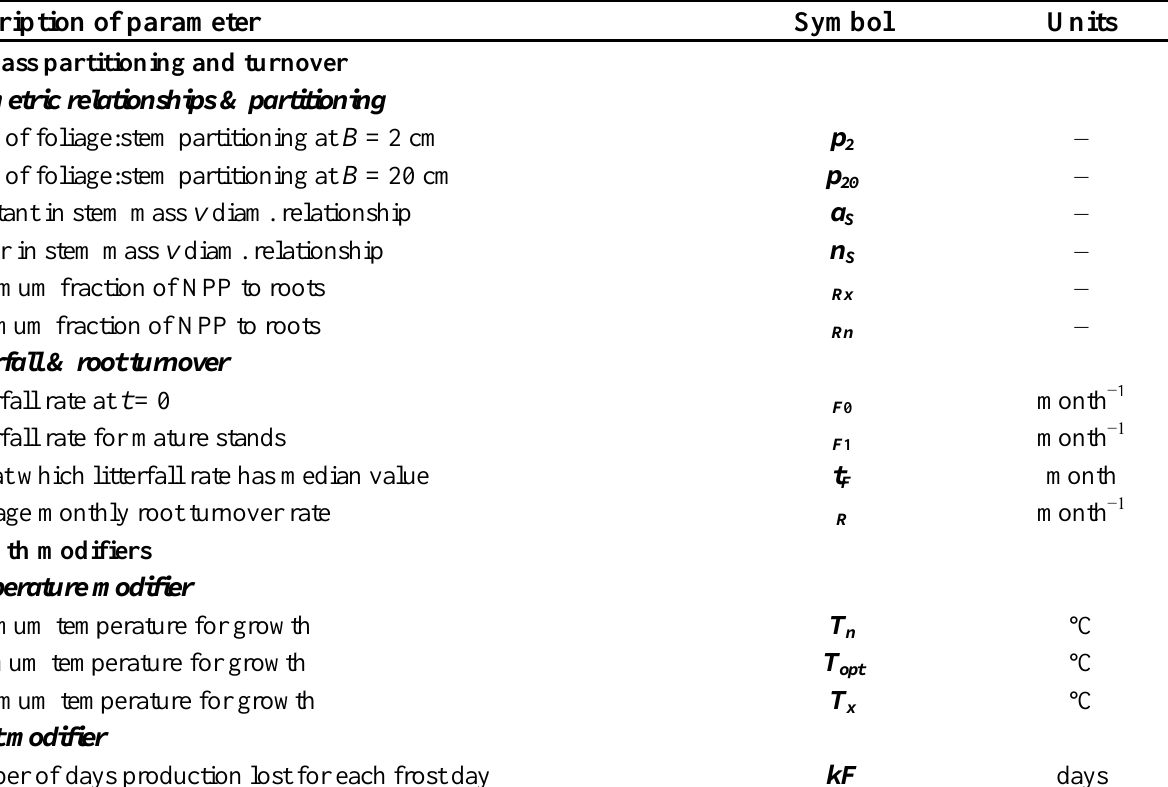
Table 1. List of all parameters of species specific with descriptions, symbols and unit. Description of parameter Symbol